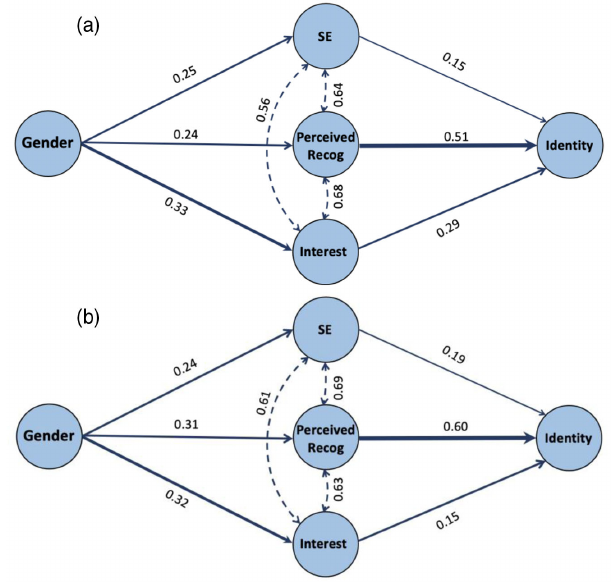
FIG. 2. Results of the path analysis part of SEM model 1, in which there are only covariances between each pair of constructs: perceived recognition (recog), self-efficacy (SE) and interest. (a) Shows the results of using physics 1 data, and (b) shows the results for physics 2 data. The dashed lines represent residual covariances between constructs. The solid lines represent re- gression paths, and the numbers on the lines are standardized regression coefficients ( β values), which represent the strength of the regression relations. Each regression line thickness qualita- tively corresponds to the magnitude of the β value. All β values shown are significant with p < 0 . 001 .